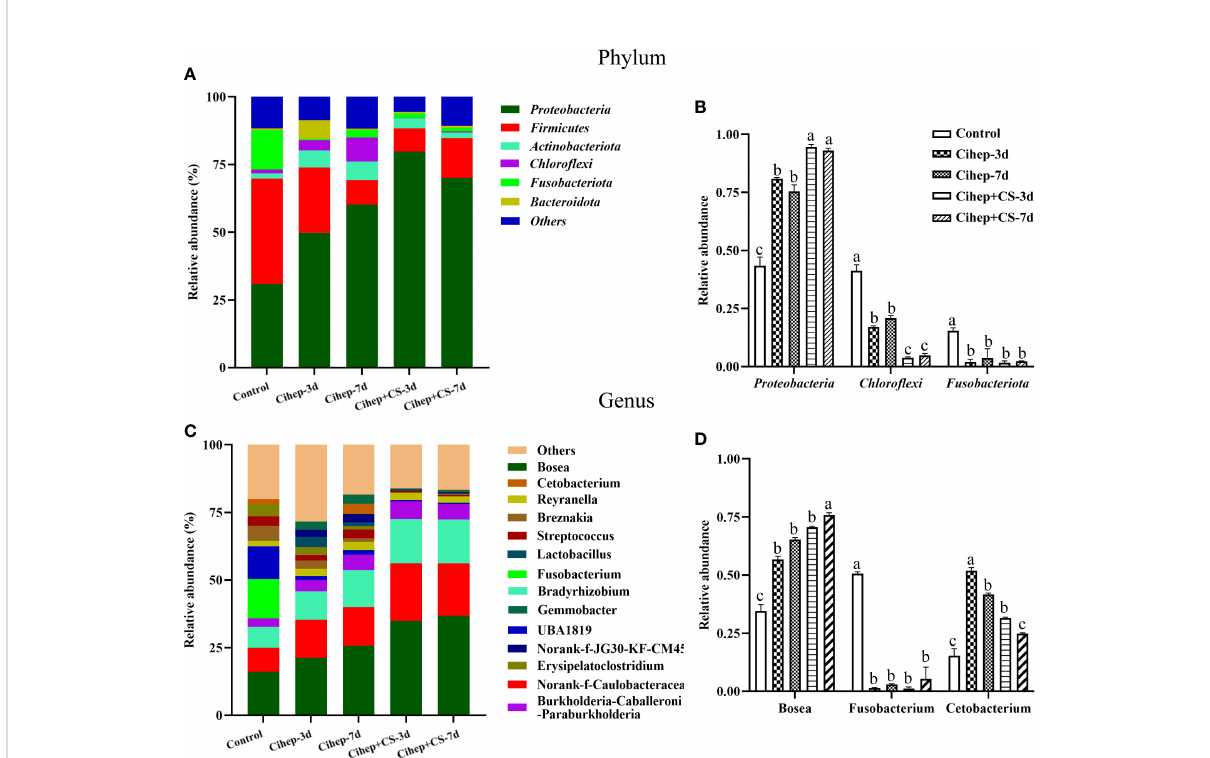
FIGURE 7 Sequencing analysis of gut microbiota species relative abundance in grass carp. (A, B) Relative abundance in phylum level. “ Others ” includes the sum of different phyla which are less than 1% in the sample. The representative differential phyla were statistically analyzed. (C, D) Relative abundance in genus level. “ Others ” includes the sum of different genera which are less than 1% in the sample. The representative differential genera were statistically analyzed. Different small letters in each group (a, b, and c) denote signi fi cant variations suggested by the multifactorial ANOVA statistics (p <